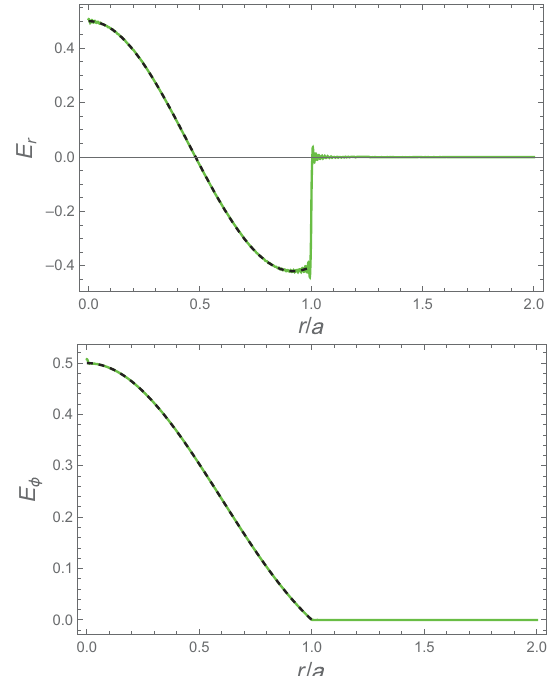
FIG. 4. Comparison of the rhs (green color line) with the lhs (dashed black line) of Eq. (28) for E upper limit of the sums truncated at 300 terms and the ð A values substituted from the results in (42) and (35). In this plot, we took r 0 =a ¼ 2 as an